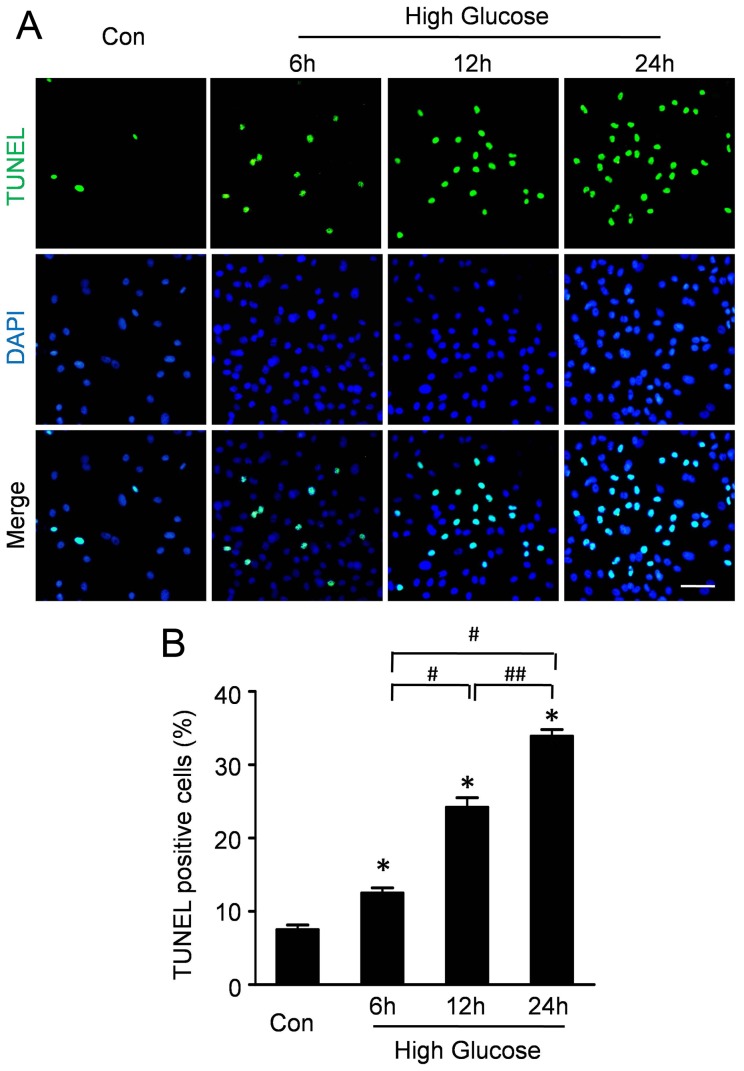
High glucose increases apoptosis of CMECs.A: Representative immunofluorescence imagines of apoptosis (TUNEL, green fluorescent) and DAPI (blue fluorescence) in CMECs under high glucose condition for the indicated time points. (Scale bars: 50 µm). B: Quantification of the apoptotic CMECs was presented as the percentage of apoptotic cells. (n = 5, *p<0.05 vs. Control, #p<0.05 vs. High glucose for 6 h, ##p<0.05 vs. High glucose for 12 h).